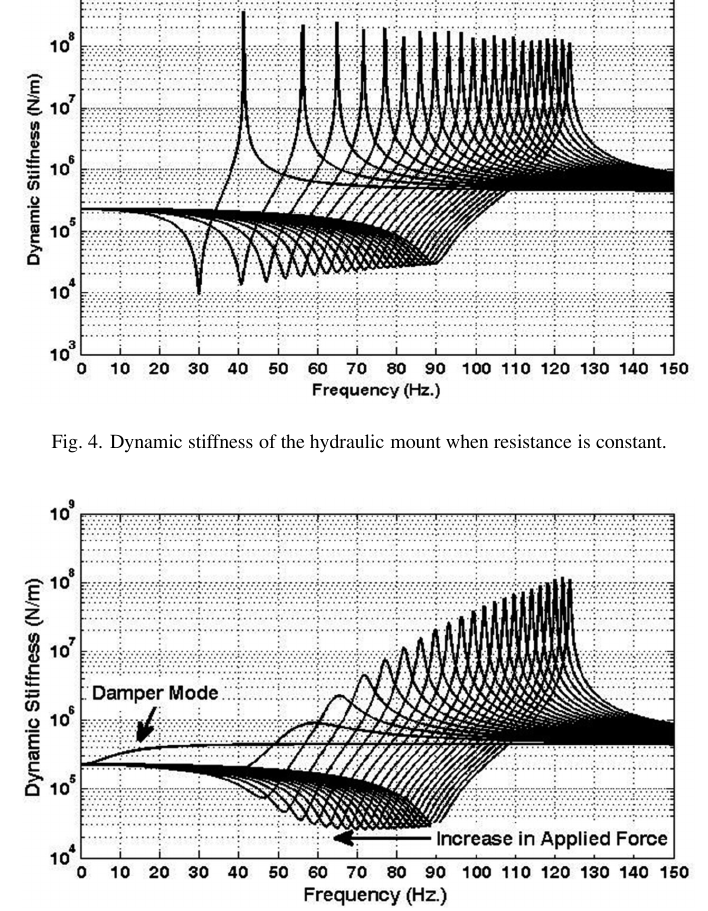
Fig. 5. Dynamic stiffness of the hydraulic engine mount.